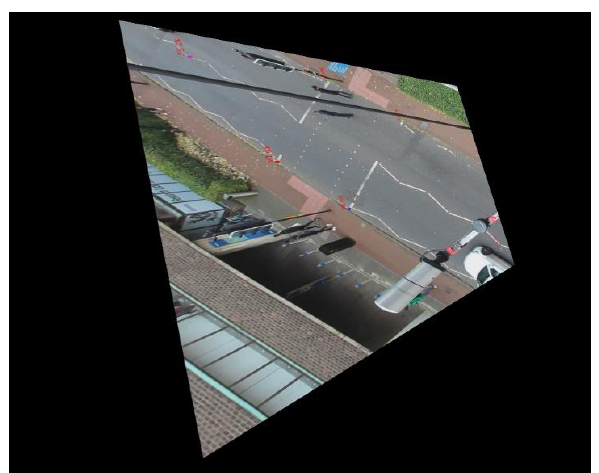
Figure 3. Transformed camera view to fit British National Grid Coordinate System